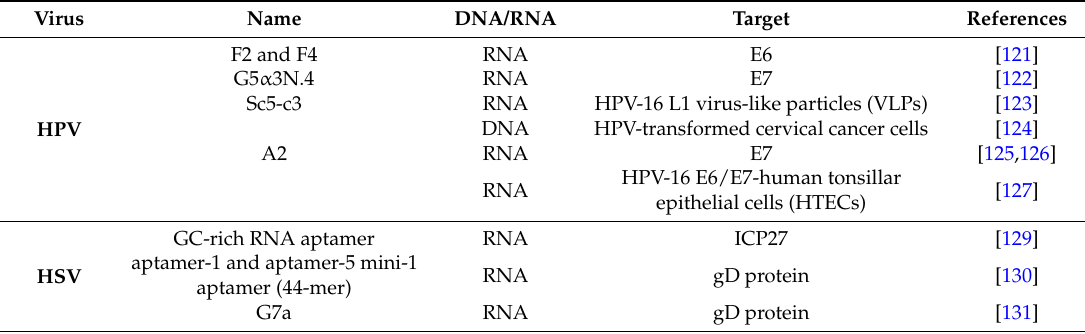
Table 5. Summary data on the aptamers selected against HPV and HSV discussed